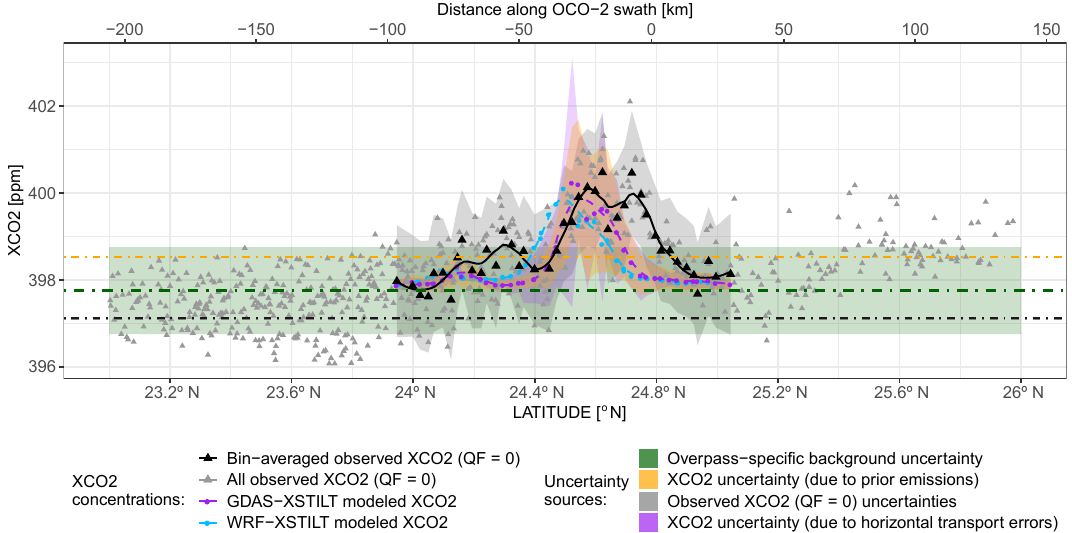
Figure 8. Latitude-series of sounding-level signal comparisons and error estimates for Riyadh. Screened observations with QF = 0 and bin- averaged observed XCO 2 are shown using gray and black triangles. GDAS- and WRF- derived XCO 2 are displayed using purple and light blue dots, with smooth splines applied to visually reveal the main variations (purple and blue dashed lines). XCO 2 errors due to errors in emissions, transport and observation are displayed using yellow, purple, and light gray shading. Overpass-specific (M3) background XCO 2 is represented using a dark green dot-dashed line with its background uncertainty displayed using light green shading. Background values using M1, M2H, and M2S are shown as orange, gray, and black dot-dashed lines, respectively. The latitudinal range for integrating XCO 2 enhancements and associated various uncertainties is ∼ 24–25 ◦ N in this case. The top x axis is the distance (in km) along the OCO-2 swath from a “minimum distance sounding” that has the smallest distance from the city